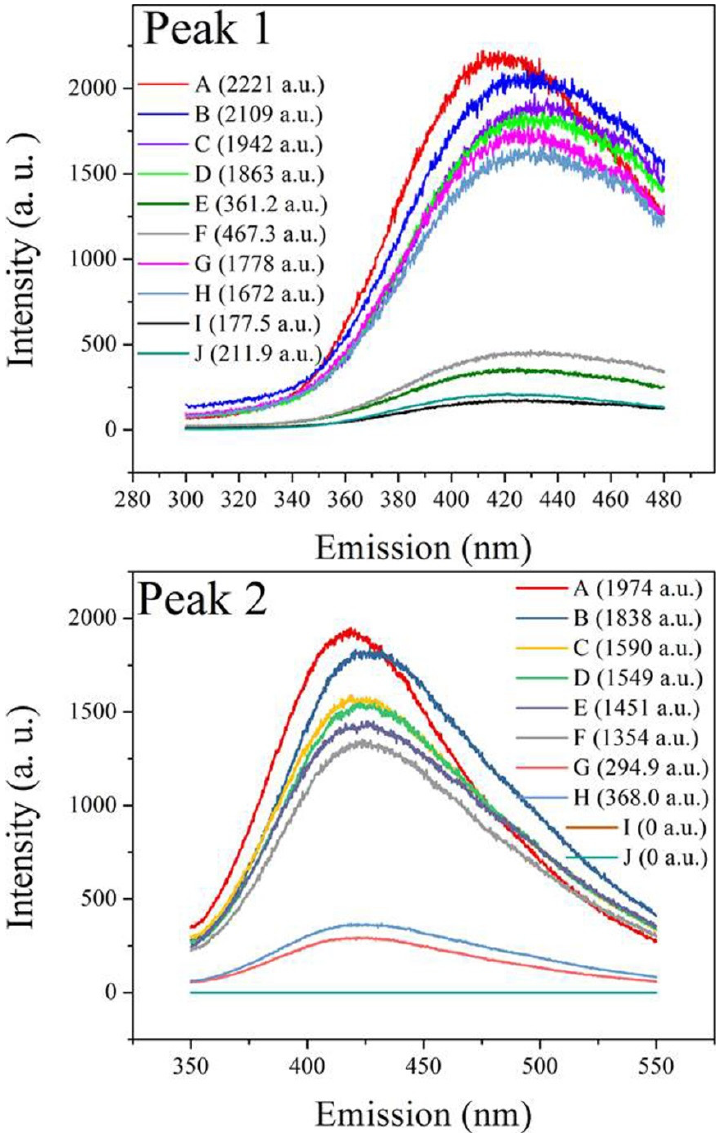
Figure 5. Changes in the intensity of the emission spectra of peak 1 and peak 2: (A) HA—pH 5.0; (B) HA—pH 7.0; (C) Cs + = 3.0 mmol/L, pH =5.0; (D) Cs + = 5.0 mmol/L, pH =7.0; (E) Cs + = 14.0 mmol/L, pH =5.0; (F) Cs + = 25.0 mmol/L, pH =7.0; (G) Co 2+ = 0.03 mmol/L, pH =5.0; (H) Co 2+ = 0.10 mmol/L, pH =7.0; (I) Co 2+ = 1.3 mmol/L, pH =5.0; (J) Co 2+ = 0.90 mmol/L, pH =7.0; HA = 50 mg/L.